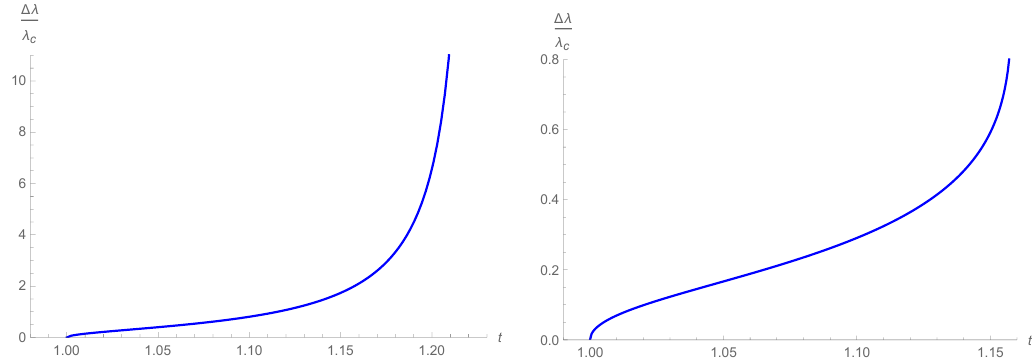
Figure 4 . Rescaled discontinuity in the Lyapunov exponent ∆ λ/λ c during the phase transition as a function of the rescaled phase transition temperature t ≡ ˜ T p / ˜ T c near the critical temperature t = 1 . Left : Massless particles on the unstable null circular geodesic; Right : Massive particles with L = 20 l on the unstable time-like circular geodesic. The parameter ∆ λ is nonzero at the first-order phase transition and vanishes at the critical point, which indicates that ∆ λ plays a role of an order